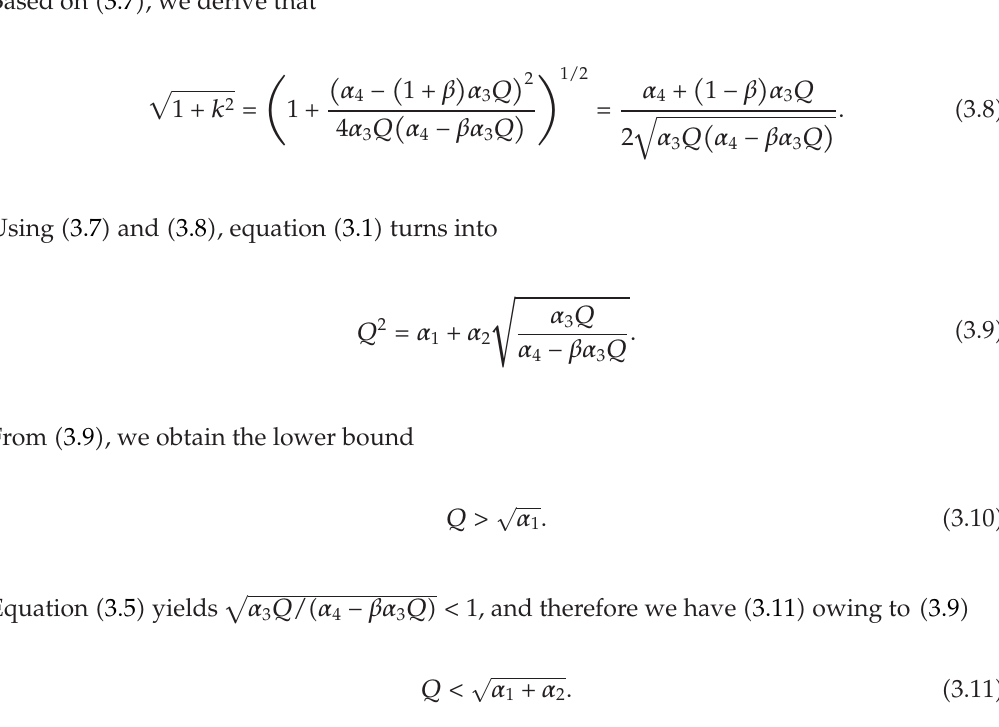
Table 1: The ratio of α 0